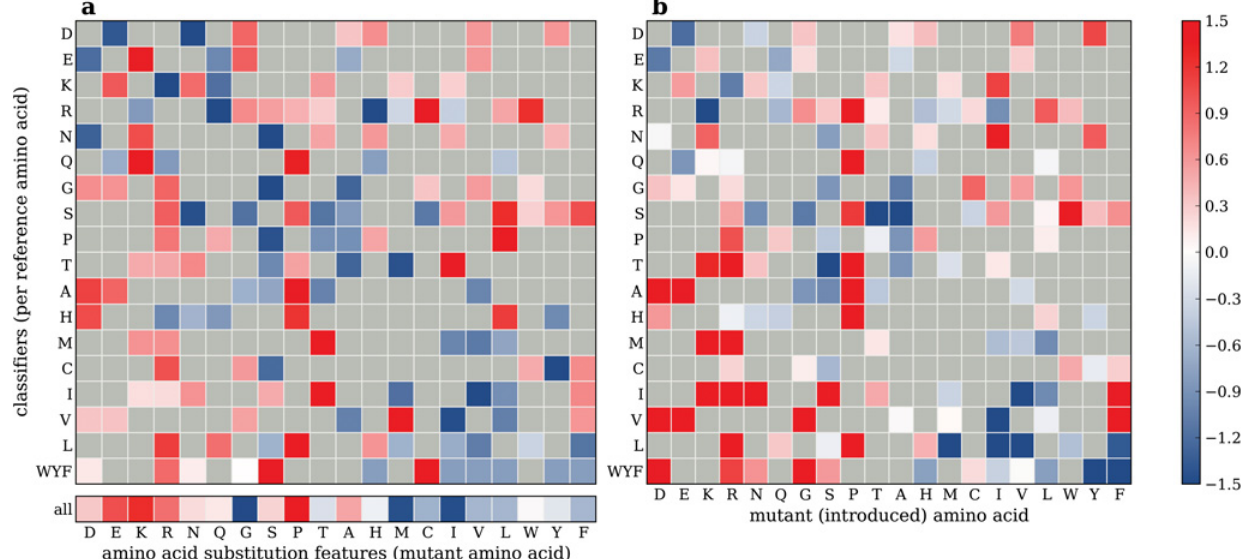
Fig 3. Amino acid substitution feature weights. a) Heat map showing feature weights obtained from classifiers trained using the amino acid substitution features. The rows show feature weights obtained per variant subset classifier. The single row at the bottom shows feature weights obtained from a classifier trained on the entire set of variants. The rows and columns are ordered based on amino acid properties [23]. Low (blue) and high (red) weights indicate that the feature is predictive for neutral and disease-associated variants respectively. Gray cells indicate amino acid substitutions that do not occur in the data set, because these substitutions require more than one mutation in the reference codon. b) Heat map showing log odds ratios between neutral and disease- associated variants that were obtained by counting the amino acid substitutions in our data set. Here, low (blue) and high (red) values indicate that substitutions occur relatively often in the set of neutral and disease-associated variants,